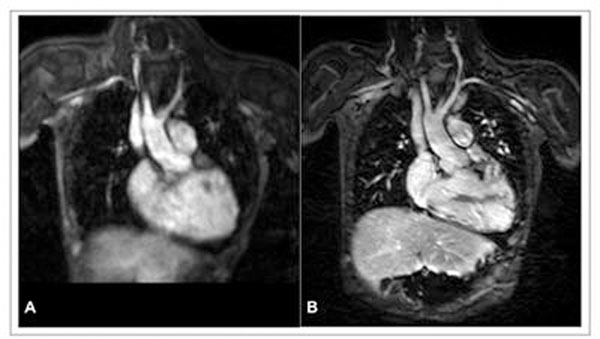
A: FF-MRA B: HR-MRA